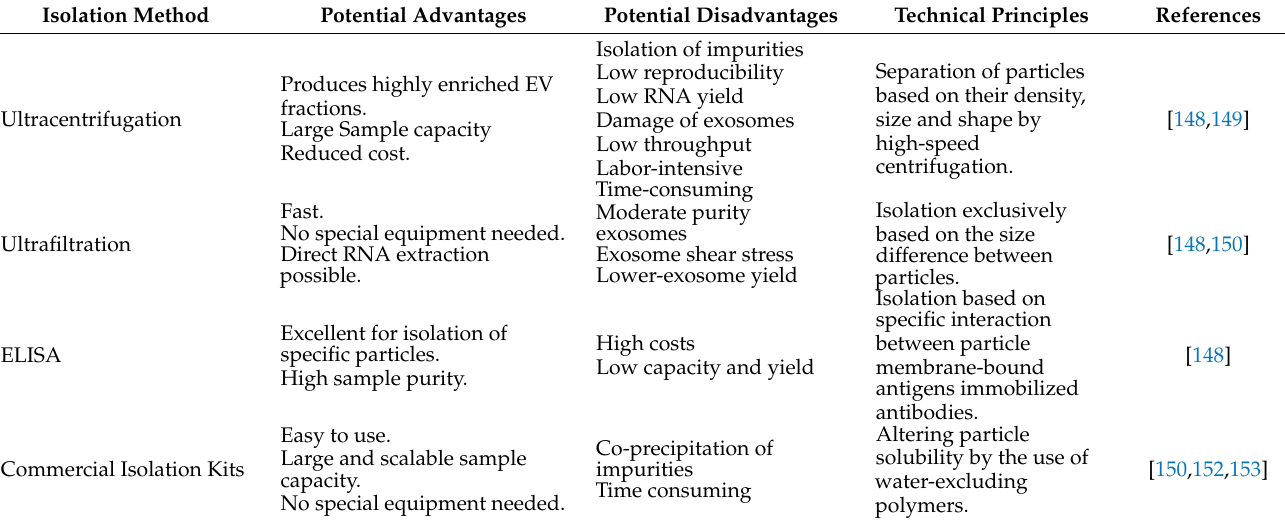
Table 3. Available exosome isolation